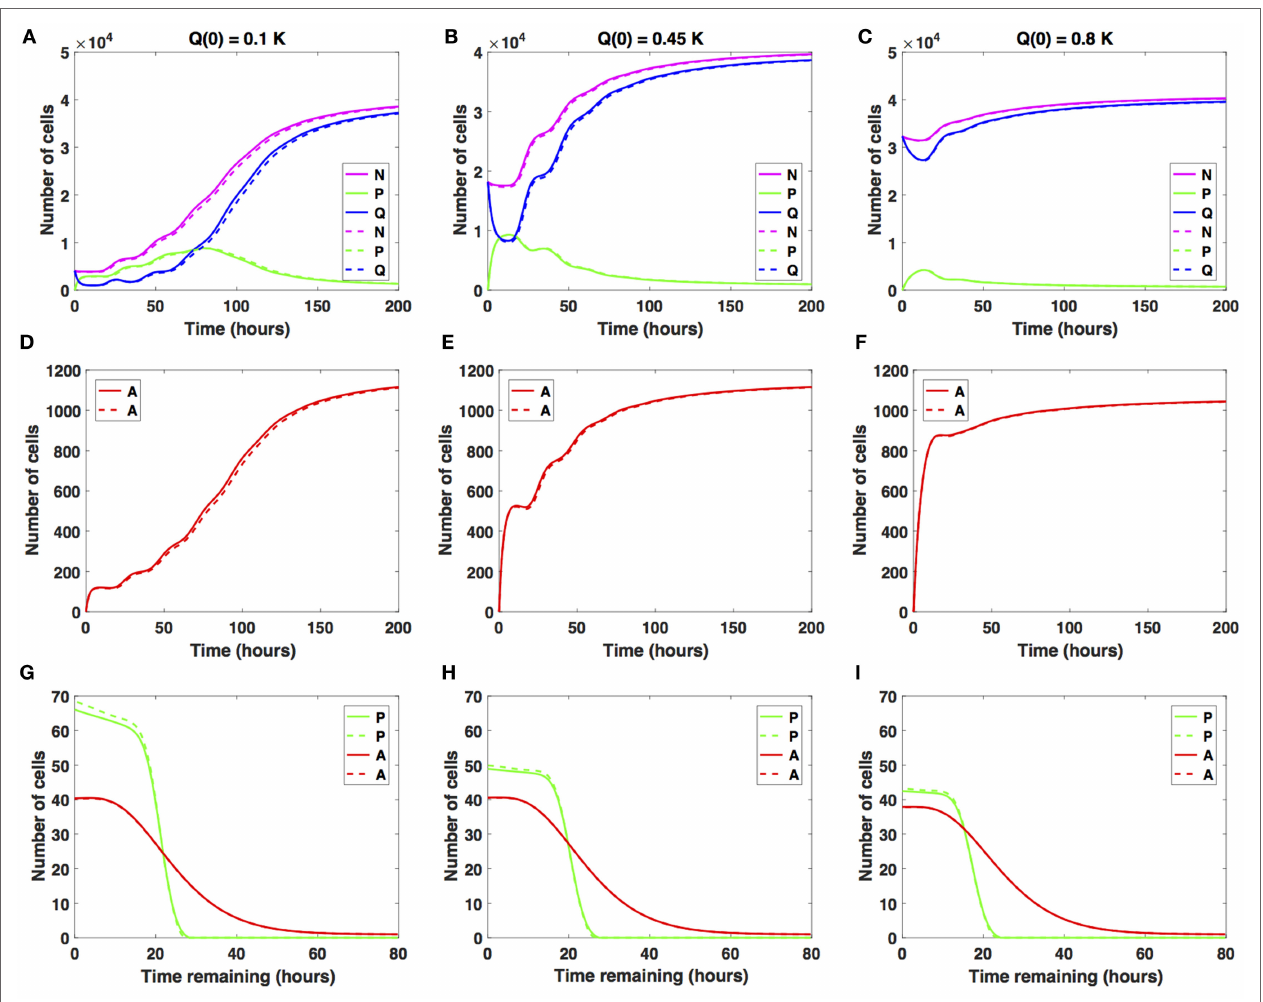
FIGURE 3 | Numerical solutions for the system (1)–(3) given small increases in the average cell-cycle length with (A,D,G) Q (0) = 10%, (B,E,H) Q (0) = 45%, and (C,F,I) Q (0) = 80% of the in vitro carrying capacity, K . The cellular dynamics in each compartment given a sustained, constant mitotic arrest or a switch-on/switch-off arrest is illustrated using solid or dashed lines, respectively. (A–C) show the dynamics of the proliferating ( P ), quiescent ( Q ), and the total number of non-apoptotic cells ( N ). (D–F) show the dynamics of the apoptotic cells ( A ). (G–I) illustrate the distribution of the times remaining to be spent by cells in the proliferative ( P ) and apoptotic ( A ) compartments as seen at the end of the simulation time, t = 200h, with (G) Q (0) = 10%, (H) Q (0) = 45%, and (I) Q (0) = 80% of plating carrying capacity, K